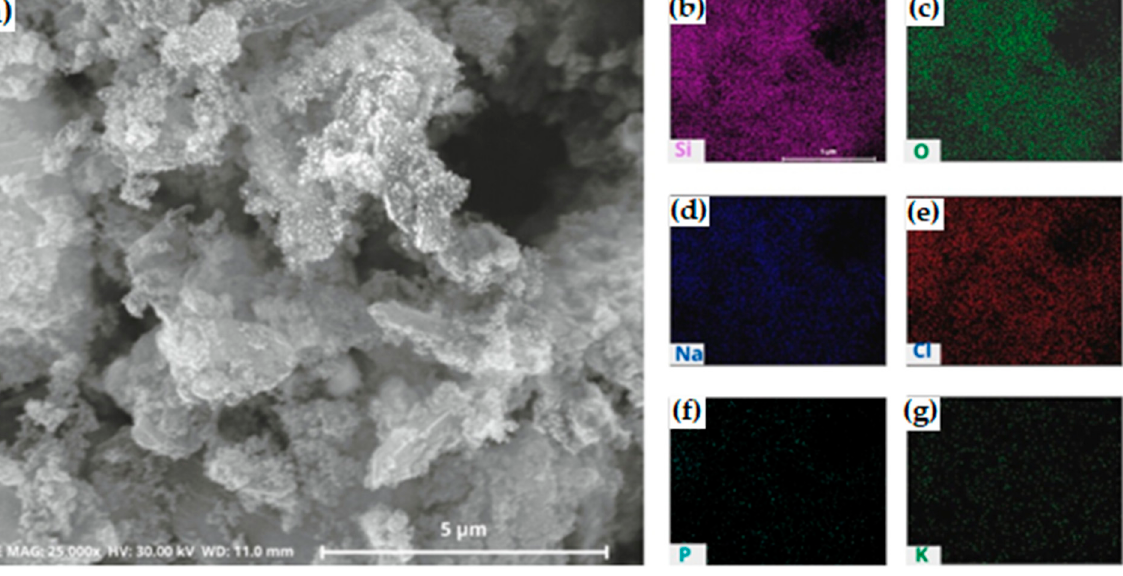
Figure 6. ( a ) SEM and ( b - g ) EDS mapping images of silica after precipitation process with HCl. The silica was synthesized at pH 2 ( b ) silicon; ( c ) oxygen; ( d ) sodium; ( e ) chloride; ( f ) phosphor; ( g ) potassium.